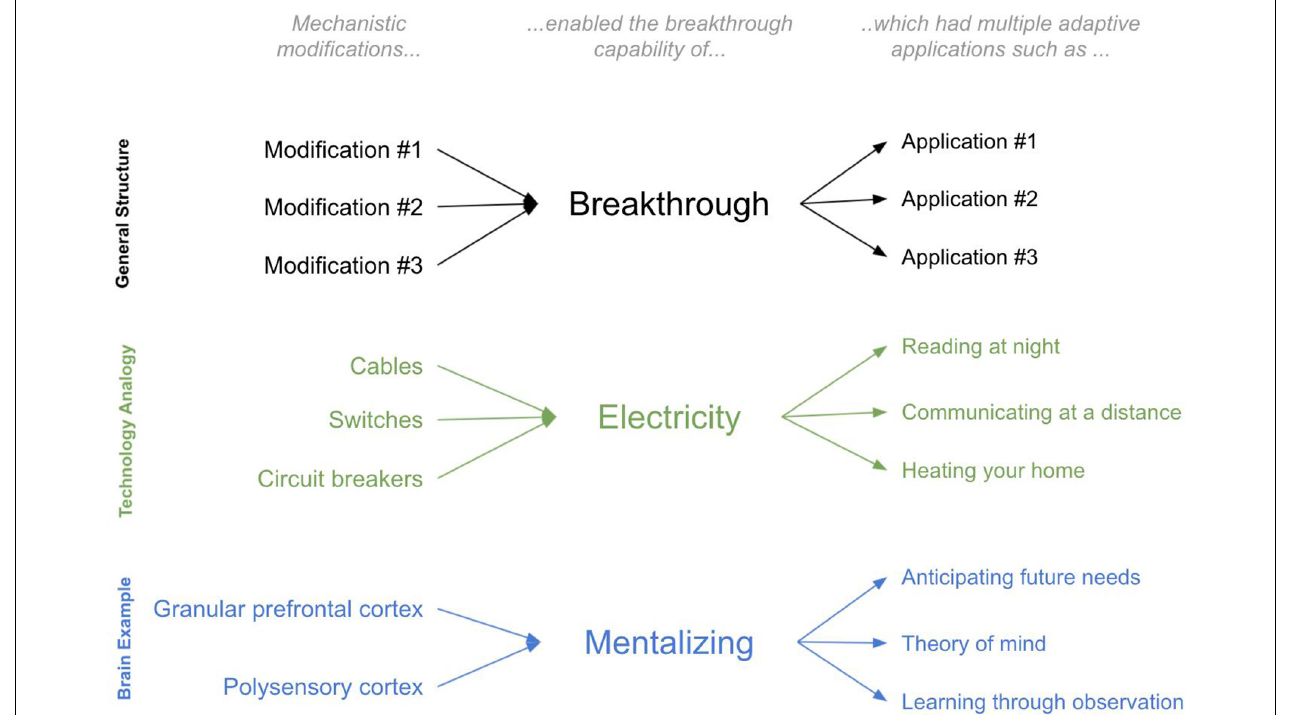
FIGURE 1 | The concept of a